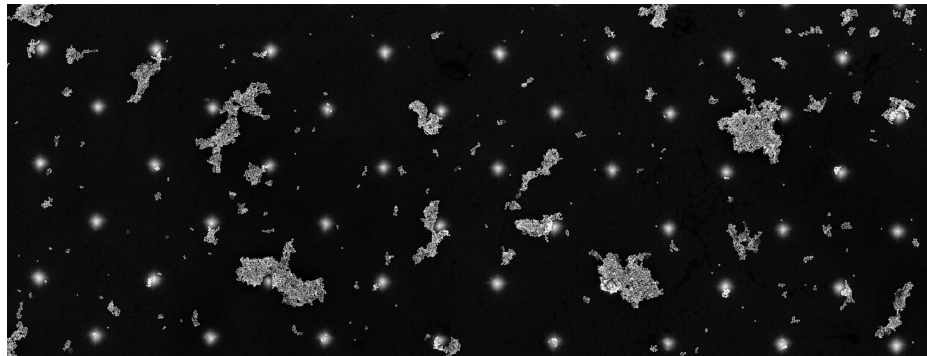
Figure 30. Aggregates of gold nanoparticles, which are seen as small bright white spots, are deposited on cone-shaped regular silicon metasurfaces; apexes of the cones are seen as a square lattice of 48 blurred specks, reprinted with permission from [18], the Optical Society (OSA).